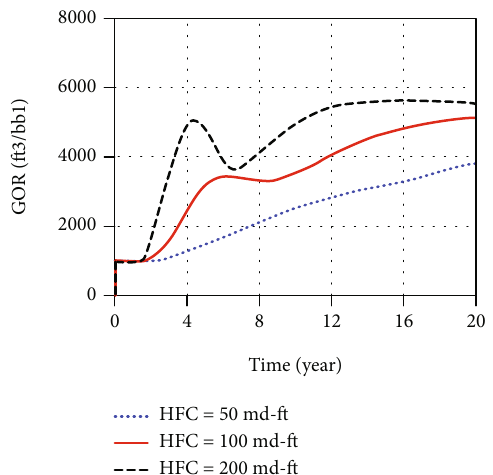
Figure 11: E ff ect of hydraulic fracture conductivity on GOR rise versus time. Fractures with high conductivity lead to a steep GOR rise rate.